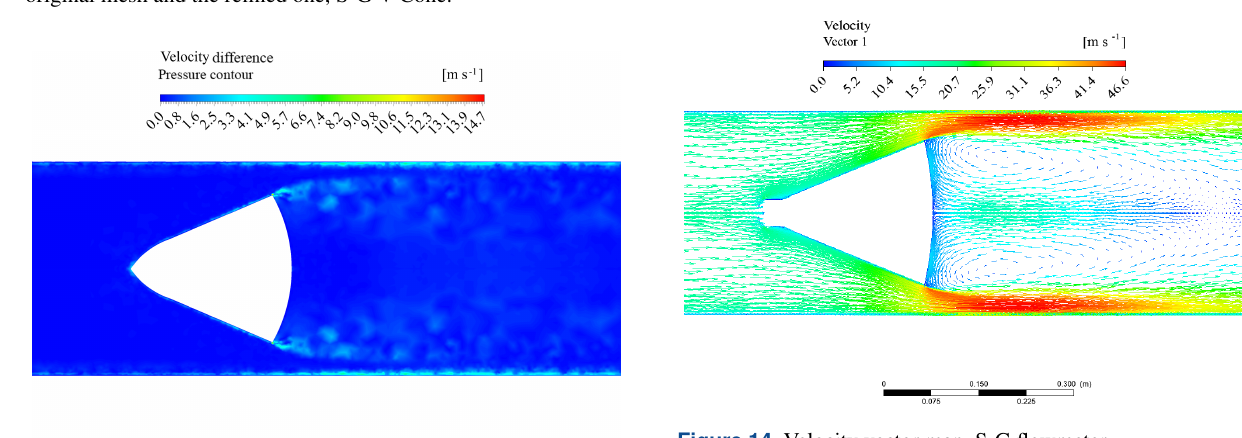
Figure 14. Velocity vector map, S-G